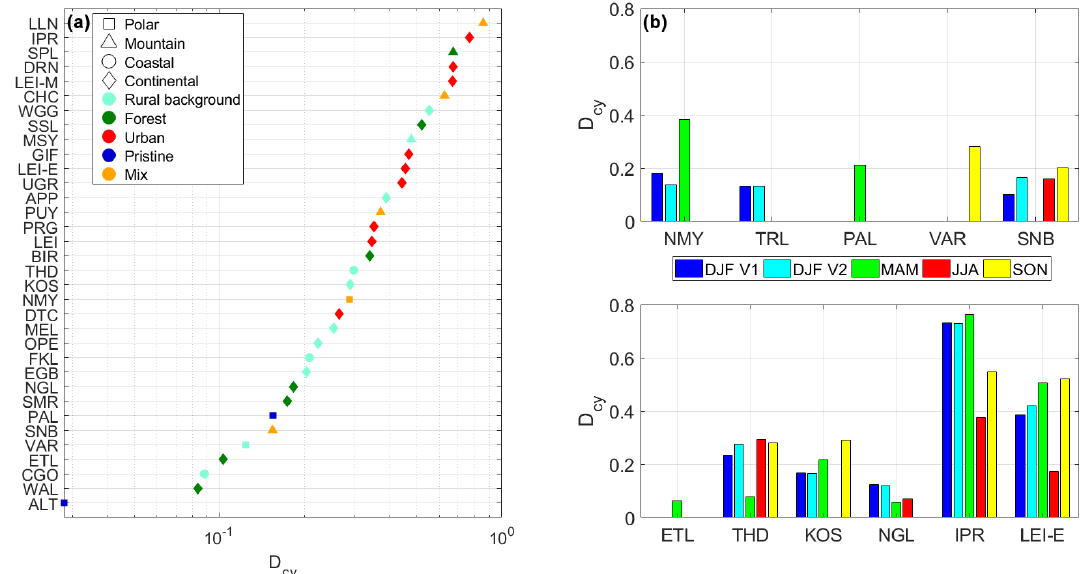
Figure 11. (a) Ranking of the stations based on the regularity of the diel cycle ( D cy ) of N tot . (b) Seasonal D cy calculated for the 11 sites with the highest coverage ( > 95%). Polar and mountain sites are shown in the upper panel, and other lowland stations are shown in the lower